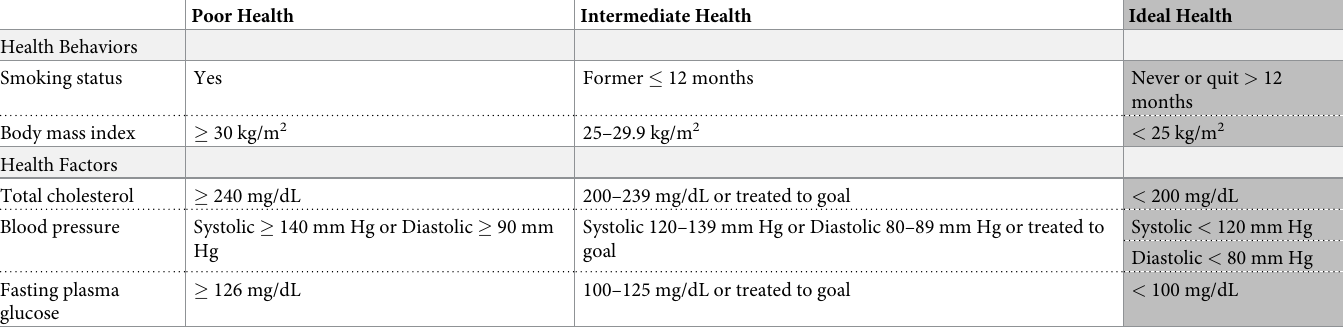
Table 1. Measures of CVH which are available in the EHR (adapted from: Lloyd-Jones, 2011) [24]. Poor